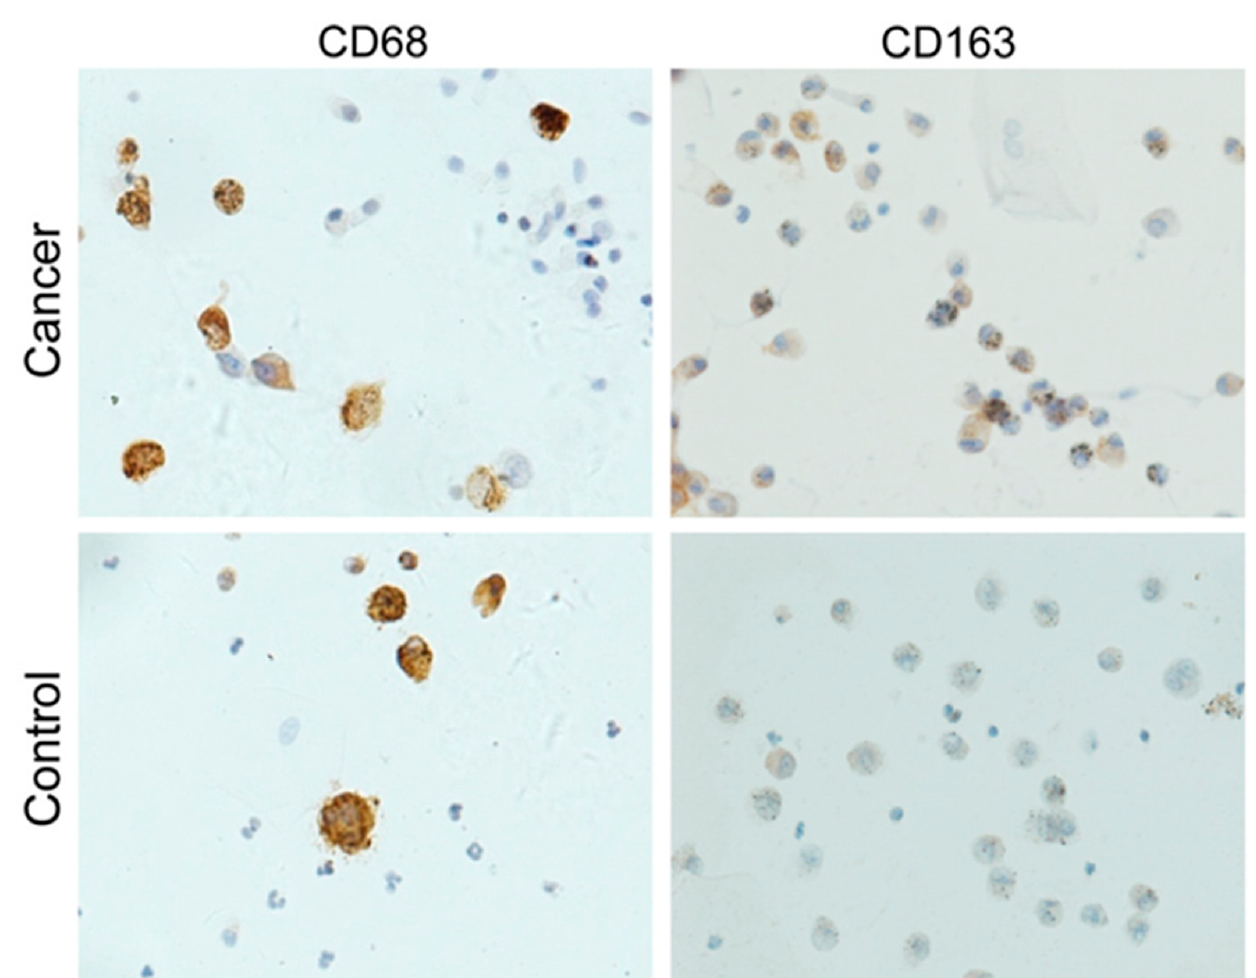
Figure 2. Immunostaining for cell epitopes in macrophages from bronchoalveolar lavage fluid samples in a lung cancer patient and healthy control. Reprinted from [48] with permission from Elsevier.